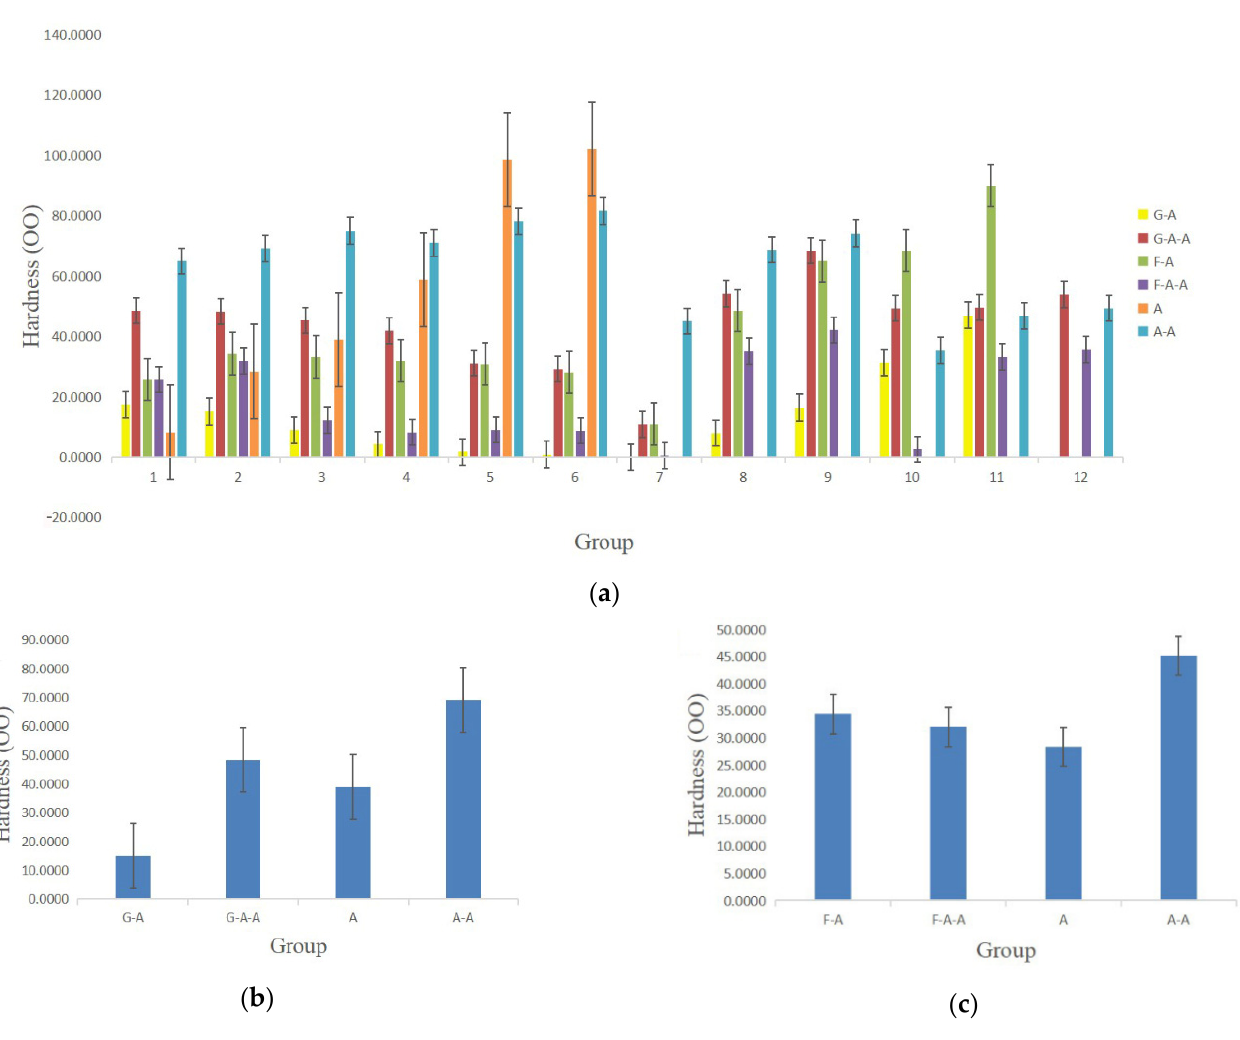
Figure 6. Hardness of the alginate-based hydrogels: ( a ) alginate (A), alginate/agarose (A-A), gelatin/alginate (G-A), gelatin/alginate/agarose (G-A-A), fibrinogen/alginate (F-A) and fibrinogen/alginate/agarose (F-A-A) groups with different components and ratios; ( b ) G-A, G-A-A, A and A-A hydrogels in Table 2; ( c ) F-A, F-A-A, A and A-A hydrogels in Table 2.